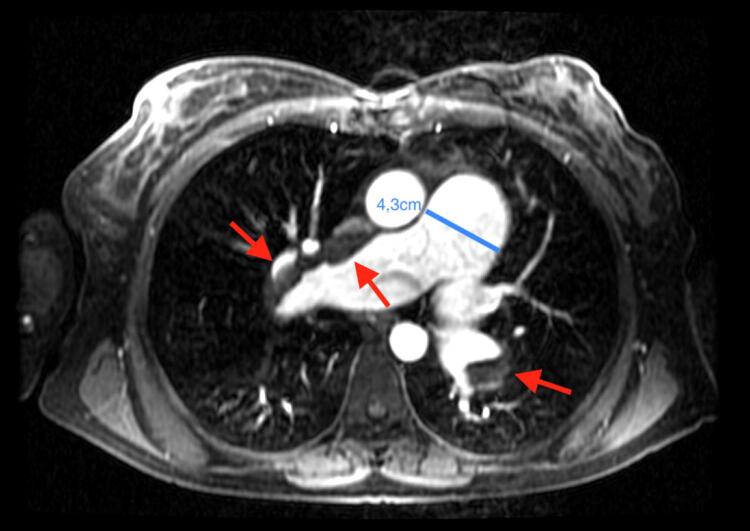
– Cardiac magnetic resonance imaging showing thromboembolism in the right pulmonary artery (red arrow) and an enlarged pulmonary artery trunk.